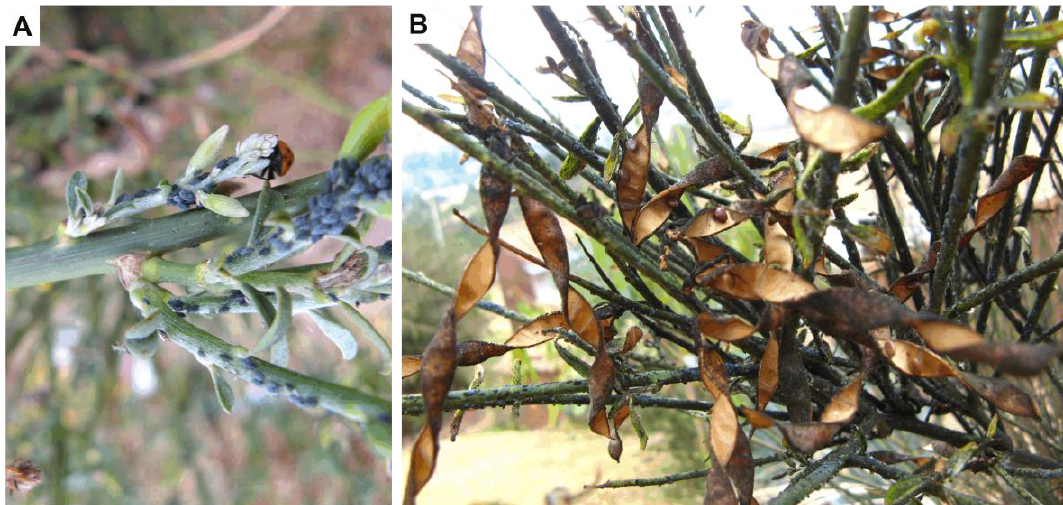
Figure 1. Images of Spartium junceum L. infested by Aphis cytisorum in the Peruvian Andes. ( A ) Apical branches, the tender region of the branch where a massive infestation of aphids can be observed. ( B ) Adult plant of S. junceum infested by A. cytisorum and sooty mold fungus Capnodium sp. (black powder that has blackened the green stems of the plant). Photos by Richard Tito.